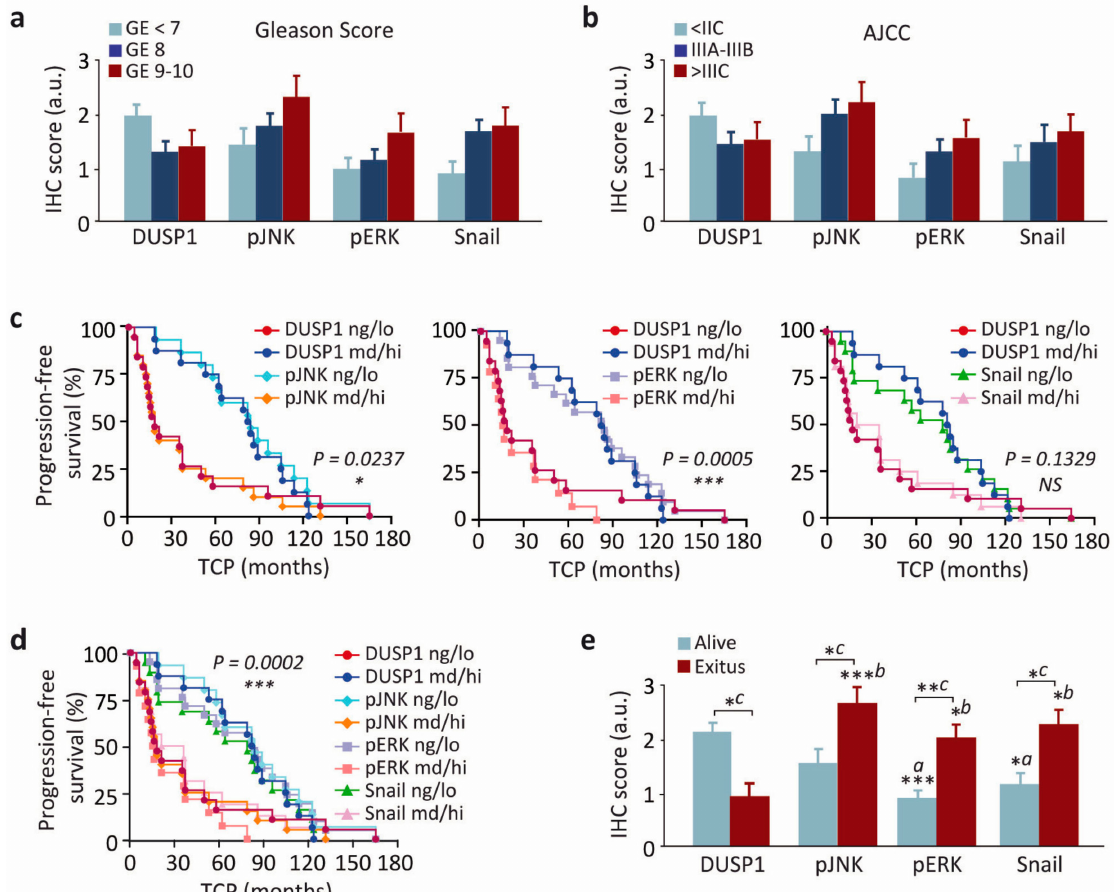
Figure 8. The relationship of DUSP1 and Snail levels and JNK and ERK activities are associated with disease progression and clinical outcome in patients with prostate cancer. ( a , b ) Immunohistochemical score for DUSP1, phosphorylated JNK and ERK (pJNK and pERK) and Snail in samples ranged into three categories based on their Gleason Score ( a ) or AJCC group staging at diagnosis ( b ). ( c ) Progression-free survival of patients showing immunohistochemical score for DUSP1/pJNK, DUSP1/pERK or DUSP1/Snail. Samples were ranged into two categories based on the staining pattern of the majority of tumor cells in the whole section (negative/low (ng/lo); moderate/high (md/hi)). ( d ) Progression-free survival of patients showing immunohistochemical score for DUSP1/pJNK/pERK/Snail. Samples were ranged into two categories as described in c . ( e ) Immunohistochemical score for DUSP1, pJNK, pERK and Snail in samples from patients either alive or dead. The statistical analysis was performed with One-way ANOVA and Dunnet ´ s multiple comparison test, and asterisks show the statistical significance of differences between the groups ( a: comparison with DUSP1 from HS-PC samples; b: comparison with DUSP1 from HR-PC samples; c: HS-PC vs HR-PC for each marker). TCP, Time to clinical progression , * 0.01 < p < 0.05; ** 0.001 < p < 0.01; *** p <